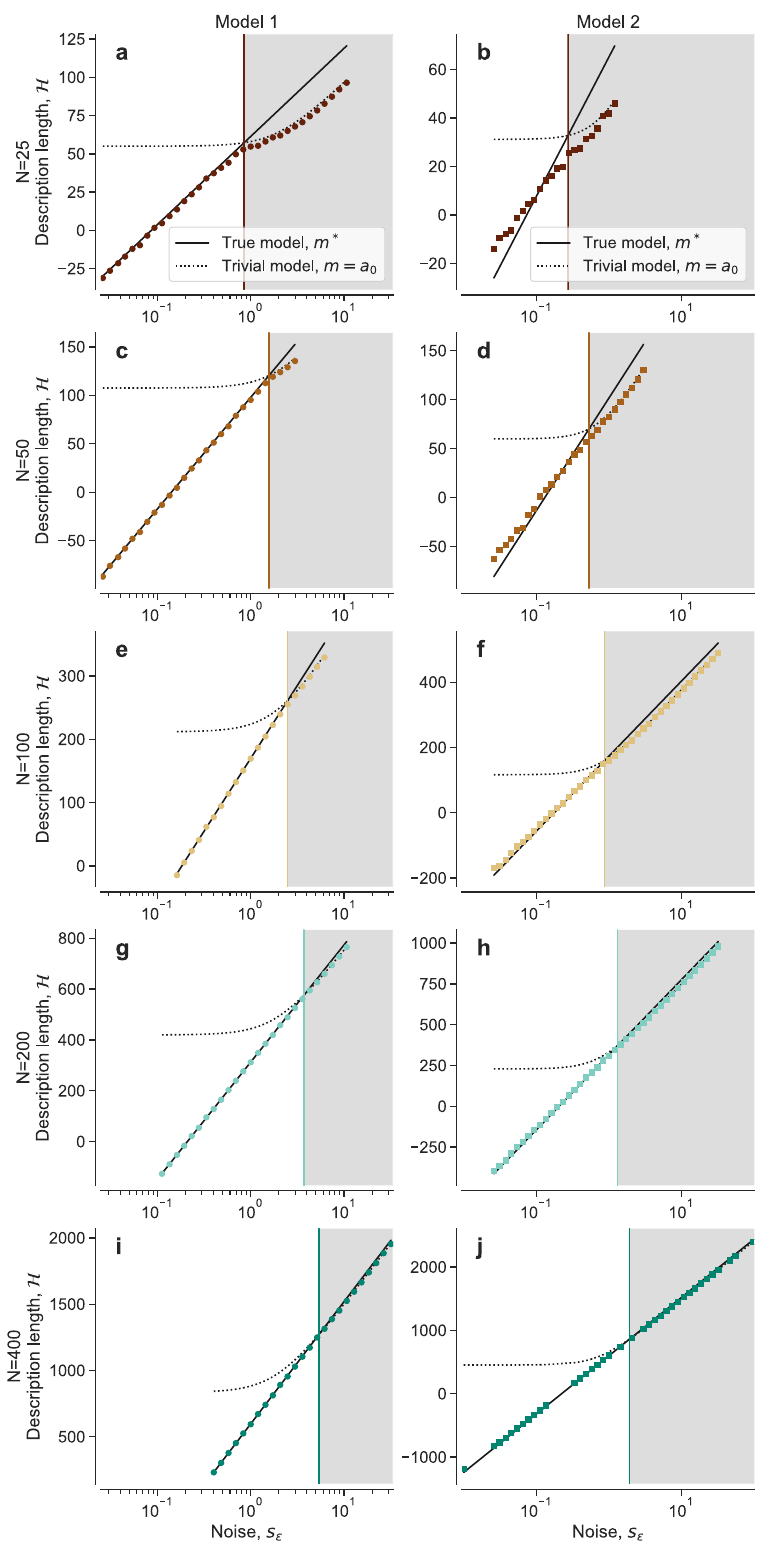
Fig.4|Modeldescriptionlengthandlearnabilityconditions. Foreachofthetwo models ( a , c , e , g , i Model 1; b , d , f , h , j , Model 2) and each size N ( a , b , N =25; c , d , N =50; e , f , N =100; g , h , N =200; i , j , N =400),weplotthedescriptionlengthofthe MDL model identi fi ed by the Bayesian machine scientist, averaged over 40 reali- zations of the training dataset D (colored symbols).For each model and N , we also plot the theoretical description length of the true generating model m * (Eq. (6);